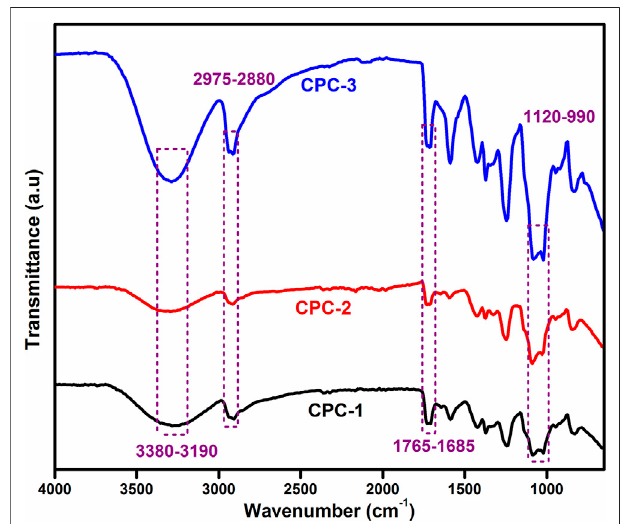
FIGURE1| FTIR spectraofCTS and PVA blendCPC-1 and crosslinked blend solution CPC-2 and drug-loaded sample